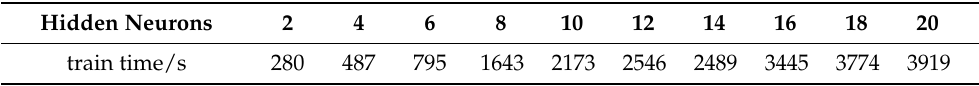
Table 4. Average training time for NN models with a different number of hidden neurons.